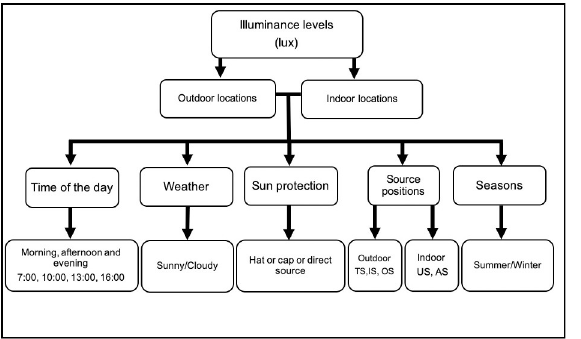
Fig 1. Overview of measured description in this study under different conditions with their illuminance levels recorded. Sensor source positions: TS—Towards the source, IS—Intermediate from the source, OS—Opposite to the source, US—under the source and AS—away from the